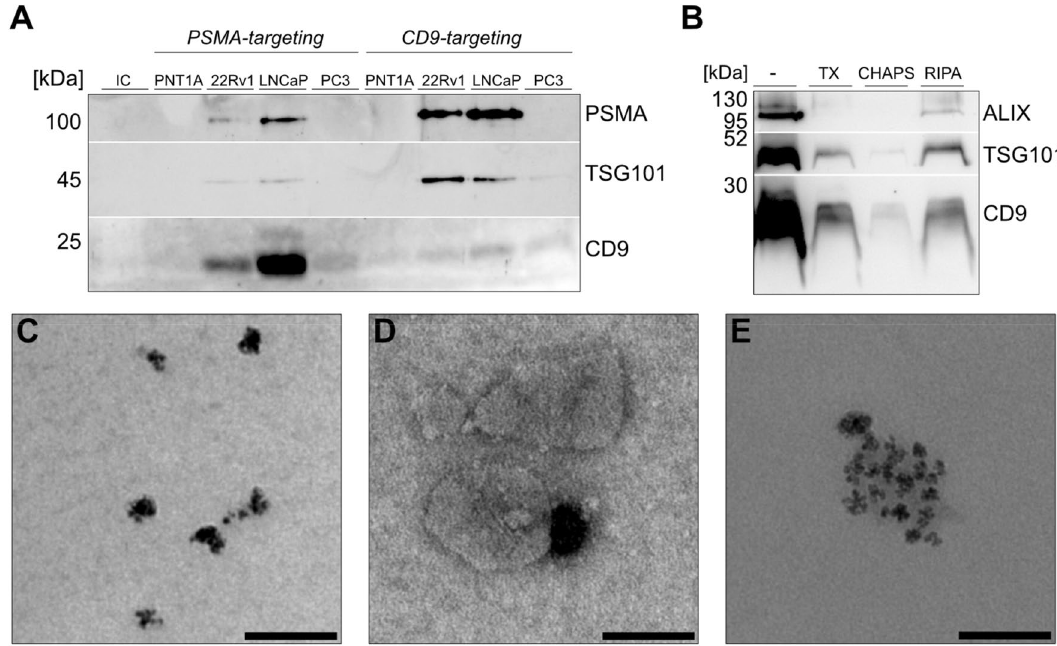
Figure 4. Immunomagnetic bead isolation of EVs targeting PSMA or CD9 from PNT1A, 22Rv1, LNCaP and PC3 ultrafiltrated supernatant after 24 or 30 h serum-free incubation of 2E+10 particles compared to the isotype control (IC) ( A ) and lysis of CD9-targeted EVs from 22Rv1 UF after Triton X-100, CHAPS and RIPA compared to the untreated control (−) by western blot ( B ) TEM of Streptavidin MicroBeads ( C ) and CD9-targeted EVs from 22Rv1 of 50 k fold magnification ( D, E ). Scale bars represent 100 nm (n =